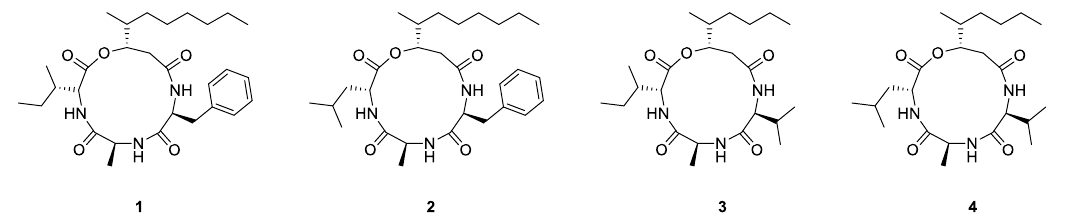
Figure 2. The structures of cyclodepsipeptides 1 – 4 isolated from culture broth of B. bassiana .